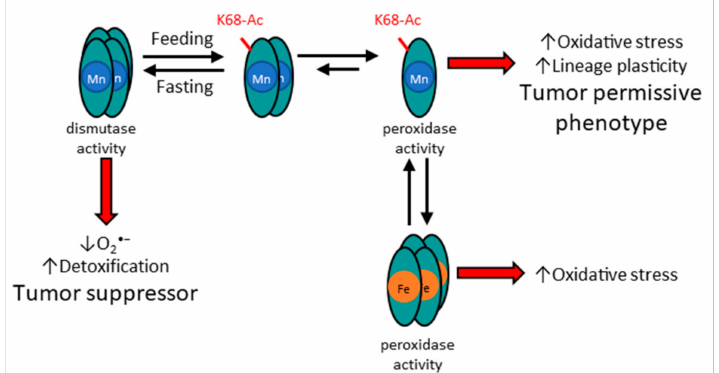
Figure 2. Acetylation status of SOD2 affects structure and function, as well as metalation status . The potential mechanism for how acetylation of MnSOD lysine 68 alters the structure and function of MnSOD enzymatic activity. In this regard, it is proposed that acetylation, for example through feeding, leads to the formation of a dimer. In addition, it is surmised that mitochondrial damage via oxidative stress, or other forms of stress, may lead to iron incorporation of